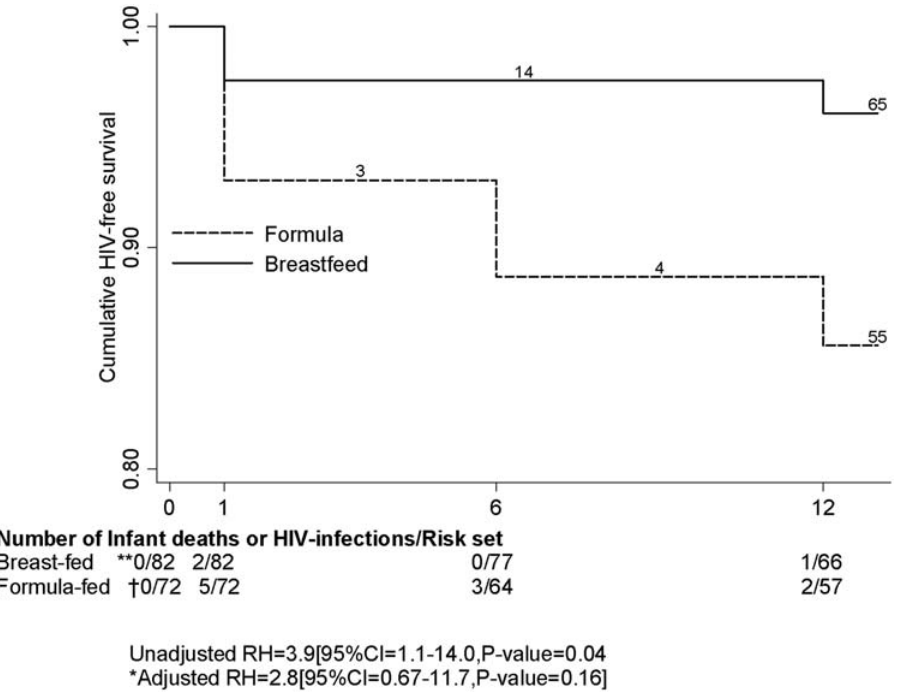
Figure 3. Kaplan-Meier cumulative probabilities of HIV-free survival by feeding group. Actual visits grouped by the three scheduled visits at one month, six months and twelve months after birth. *Adjusted for maternal age and maternal antiretroviral therapy. ** Twenty five observations left-censored for the following reasons: 12 babies were HIV-positive at one month without HIV results at birth, 9 were not tested for HIV at one month, and 4 losses to follow-up. { Three infants who were HIV-positive at one month were left-censored.